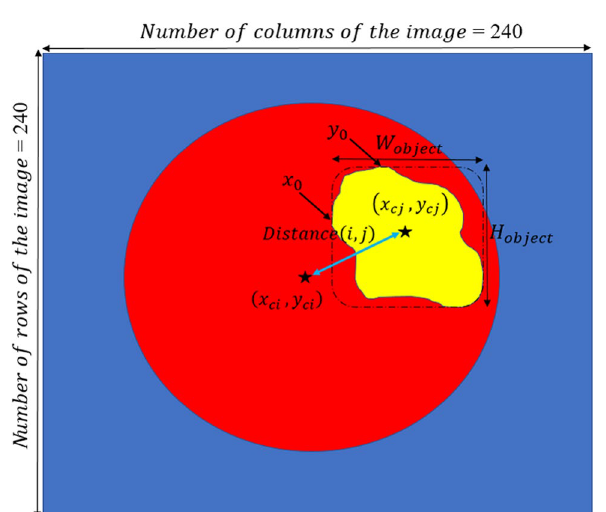
Figure 8. An example depicting the whole brain and its corresponding binary mask for two modalities. The expected area is shown in the third column. The center of the binary mask and the expected area is shown by a red star.